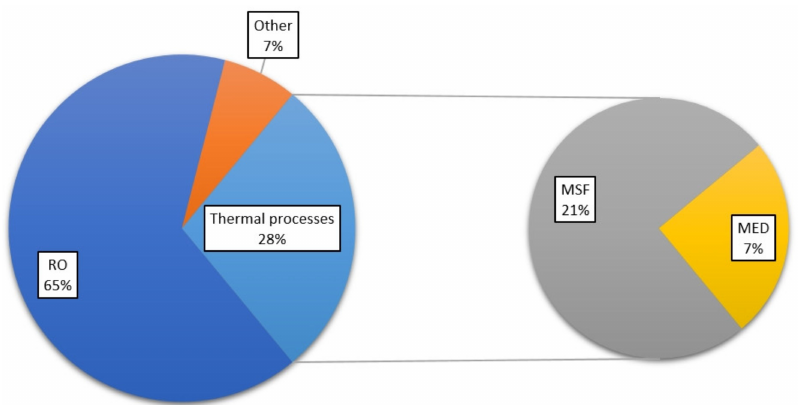
Figure 1. Distribution of desalination technologies.